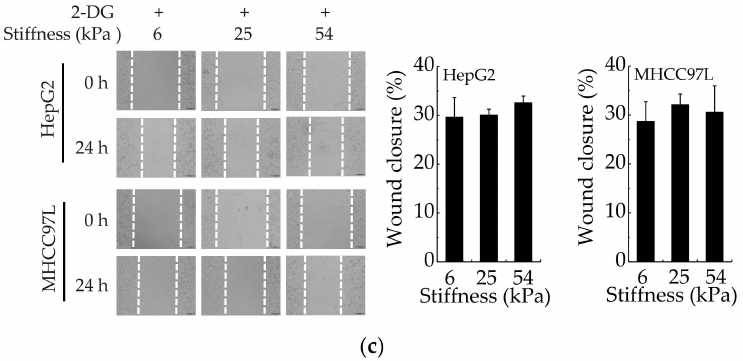
Figure 3. Aerobic glycolysis is responsible for sti ff er ECM-mediated migration. ( a ) Western blot analysis showed the protein expression of HKII in HepG2 and MHCC97L after knockdown of HKII ( n = 3, ** p < 0.01 versus control-siRNA group). ( b ) Transwell analysis of HKII-knockdown HepG2 and MHCC97L cells migration (Scale bar: 100 µ m; n = 3, ** p < 0.01). ( c ) Wound scratch assay analysis of HepG2 and MHCC97L cells after treatment with 2-DG (20 mM) (Scale bar: 100 µ m; n = 3).